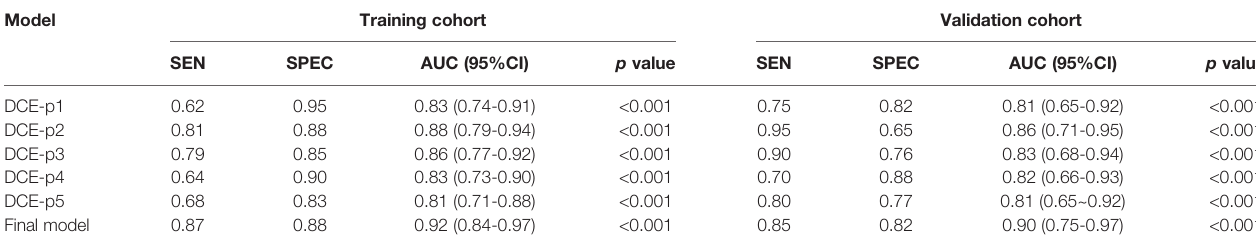
TABLE 2 | Performance of single phase enhancement and the fi nal model of radiomics analysis. Model